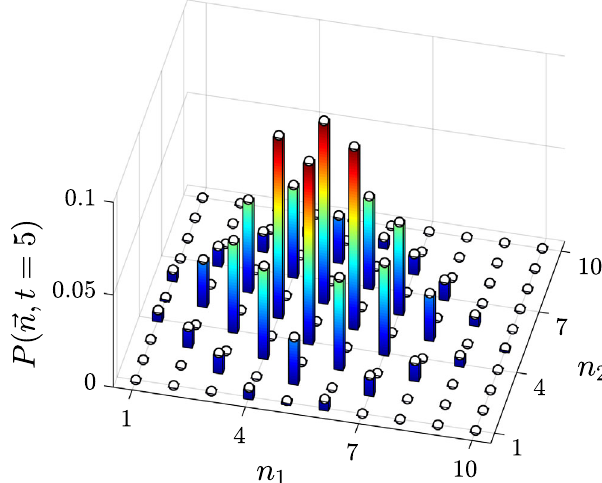
FIG. 3. Two-dimensional propagator in a lattice with reflecting boundaries and size N ¼ M ¼ 10 at time t ¼ 5 starting from the initial condition P ð n 1 ; n 2 ; 0 Þ ¼ δ are obtained from the analytic expression in Eq. (21) with q 1 ¼ q 2 ¼ 1 , while the colored bars are obtained by iteratively solving Eq.